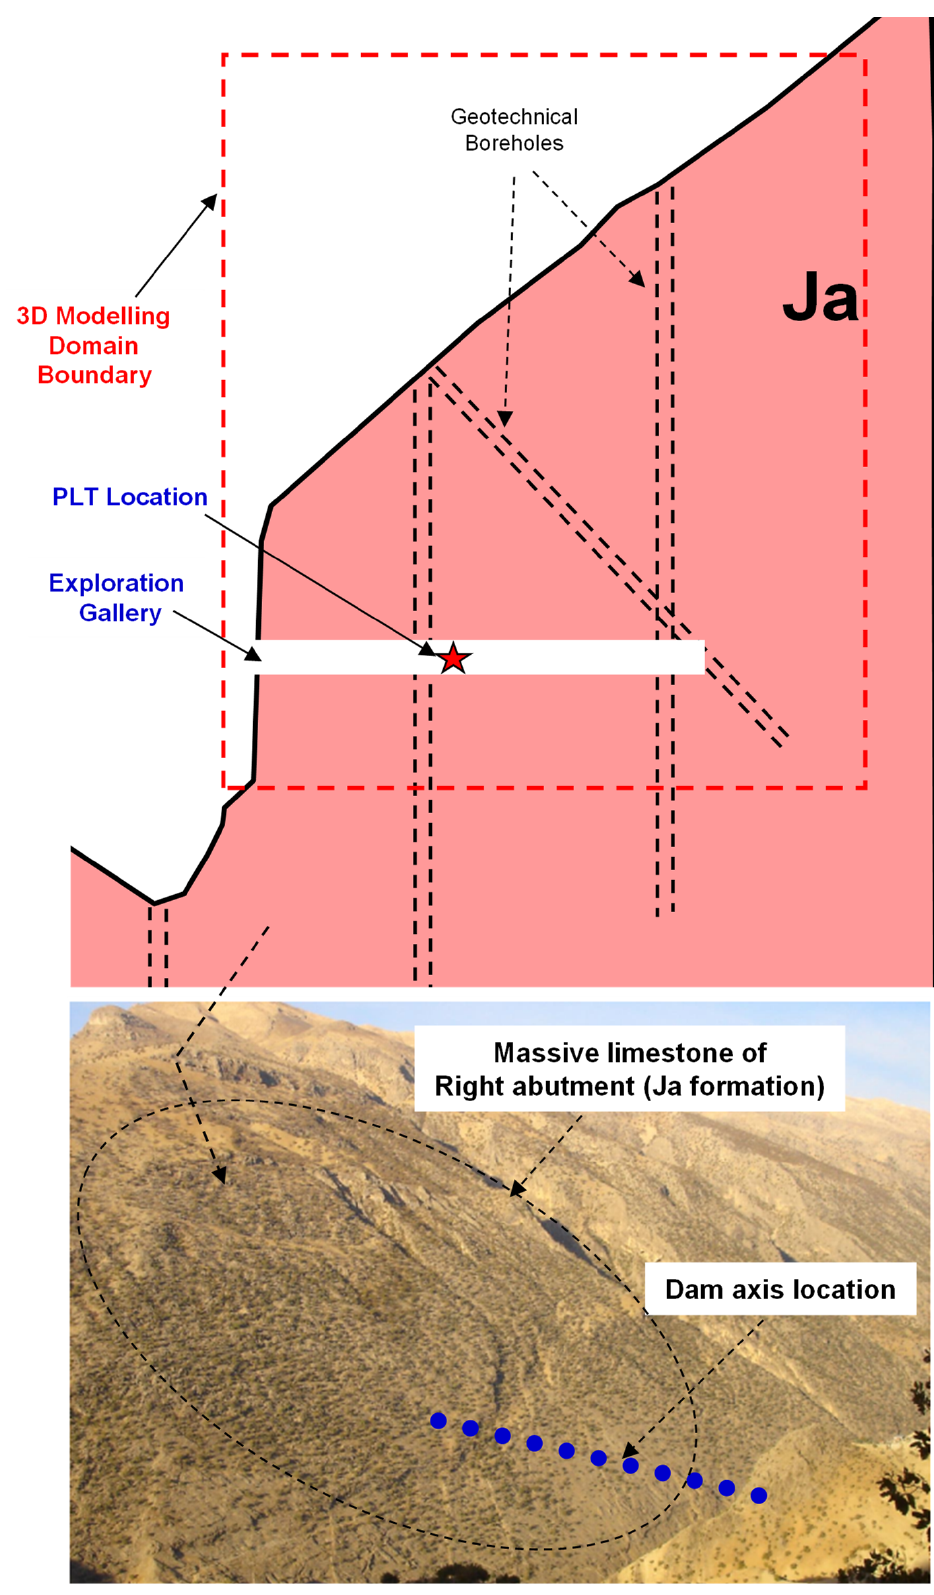
Figure 3. Magnified views of the right abutment, conducted PLT location, and modelling domain boundary.